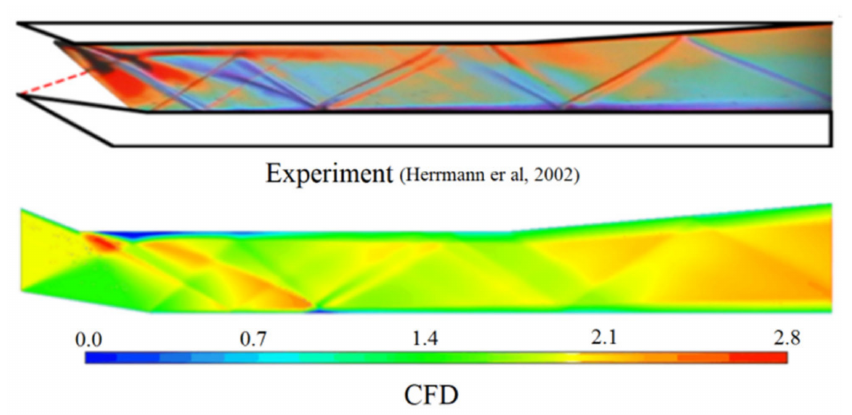
Figure 6. Comparison of the Mach number between the schlieren [31] and numerical